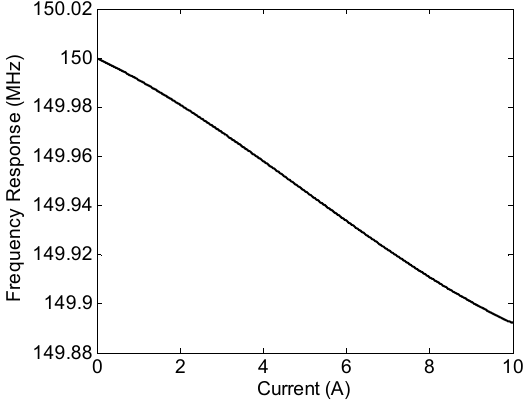
Figure 5. The calculated sensor response of FeNi coated SAW current sensor.